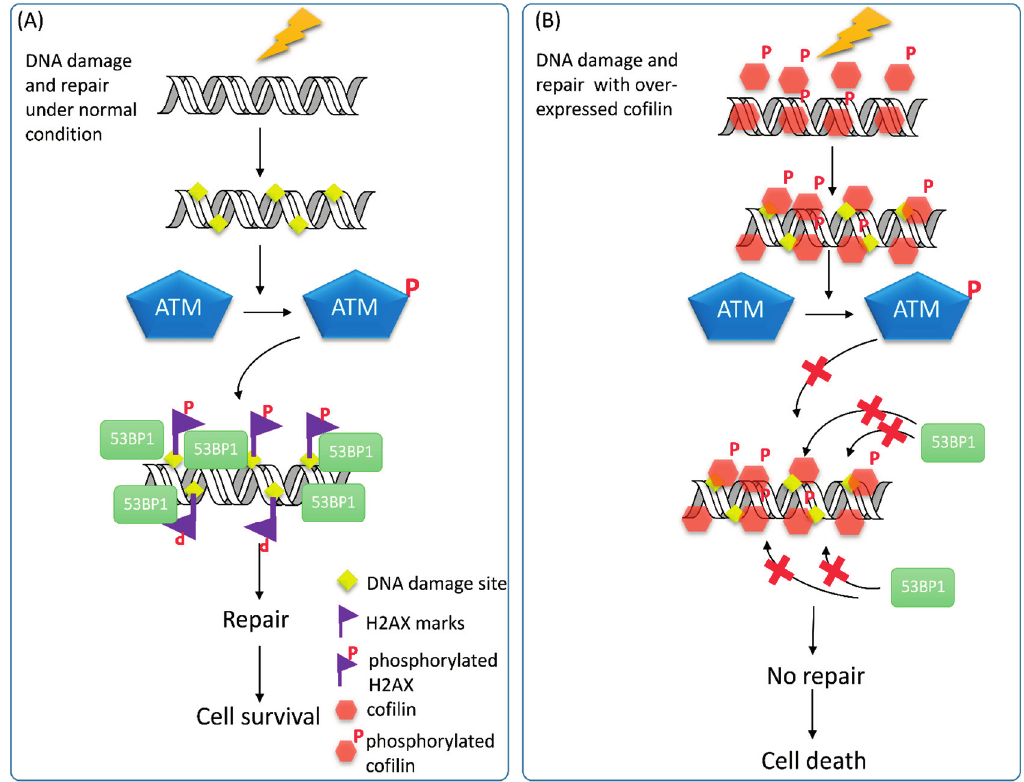
Figure 5. The putative effects of over-expressed CFL-1 on DNA repair. ( A ) Under normal condition, IR-induced DNA damage will trigger the activation of the ATM kinase, which phosphorylates H2AX encompassing DNA damage sites. 53BP1 will recognize γ -H2AX and recruit additional DNA repair molecules to fix the damaged DNA and lead to cell survival; and ( B ) Over-expression of wild type CFL-1 (phosphorylatable) may enter and locate around DNA. After IR, the ATM kinase remains to be activated, but cannot phosphorylate H2AX. Recruitment of 53BP1 to the γ -H2AX sites fails, so that the DNA repair capacity is impaired and results in cell